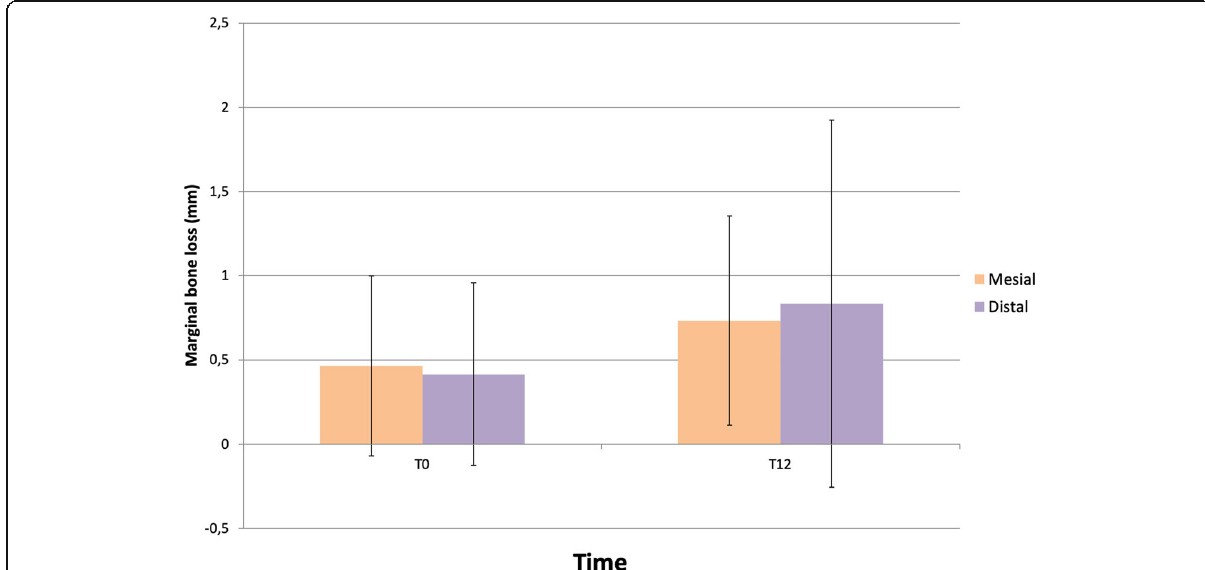
Fig. 5 Marginal bone loss at mesial and distal